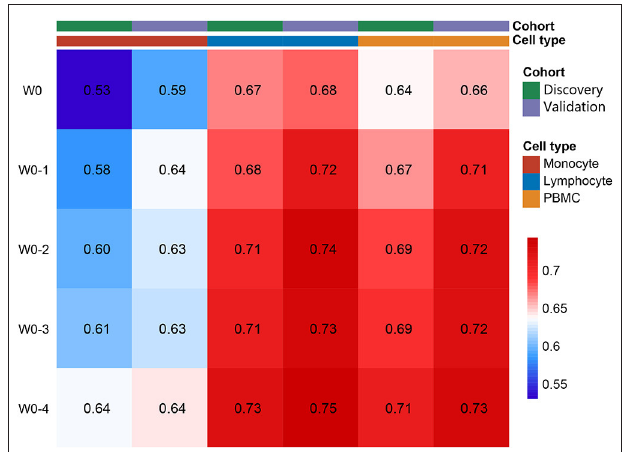
FIGURE 2 | Average lymphocyte, monocyte, and peripheral blood mononuclear cell (PBMC) as risk factors for 6-month mortality. Value in each single block presented the C-index for corresponding biomarkers to predict the